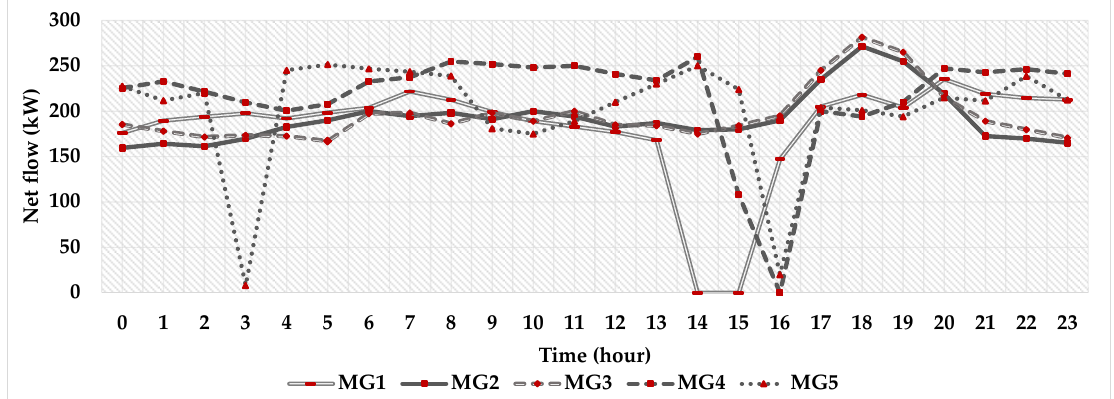
Figure 7. Net flows of the five MGs with the self-ESS-scheduling.